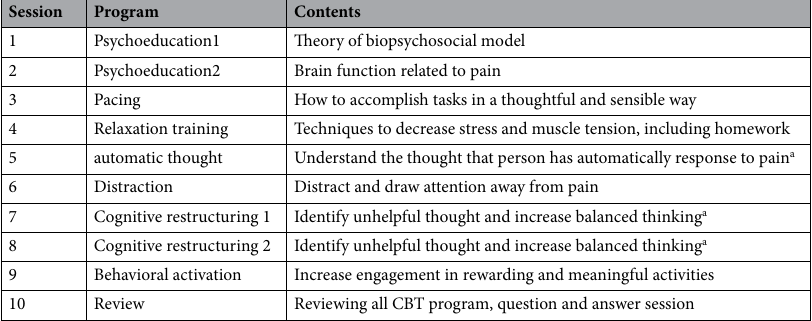
Table 1. Protocol of CBT. a Including homework.